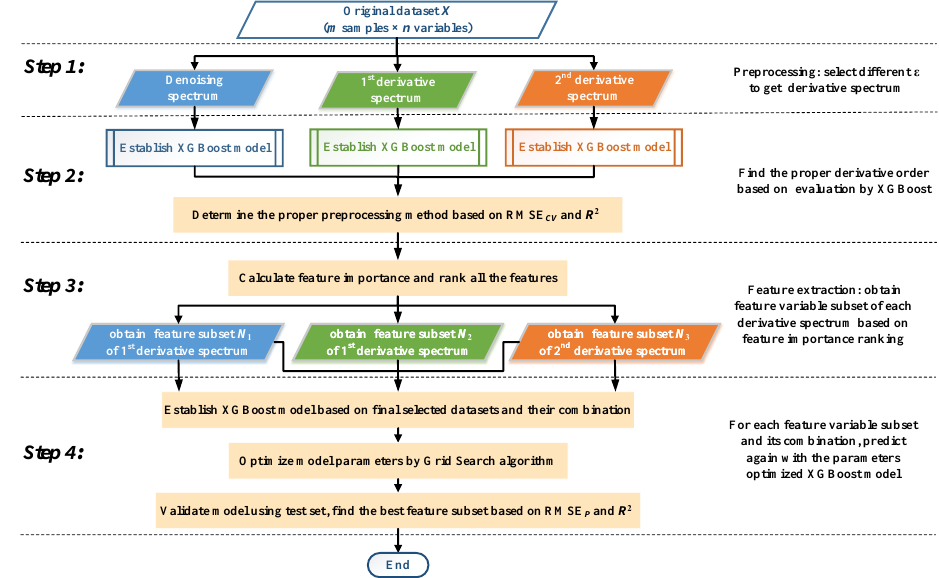
Figure 4. Flow chart of the proposed singular perturbation spectral estimator (SPSE)-XGBoost